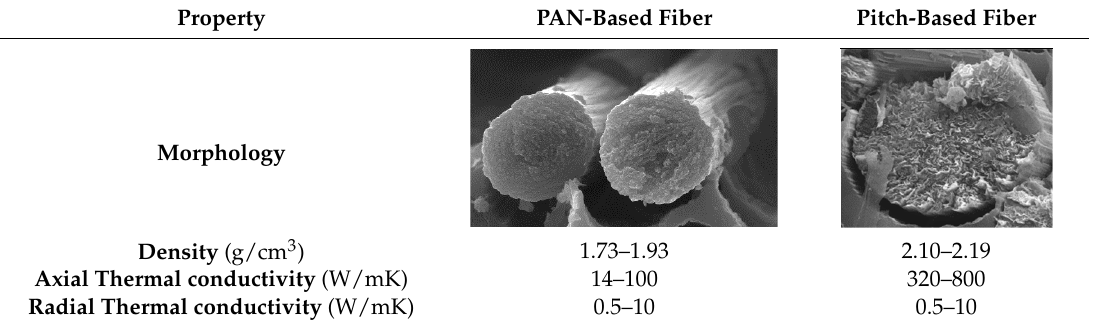
Table 1. Comparison of polyacrylonitrile (PAN) and pitch-based carbon fibers data values from [11–13].